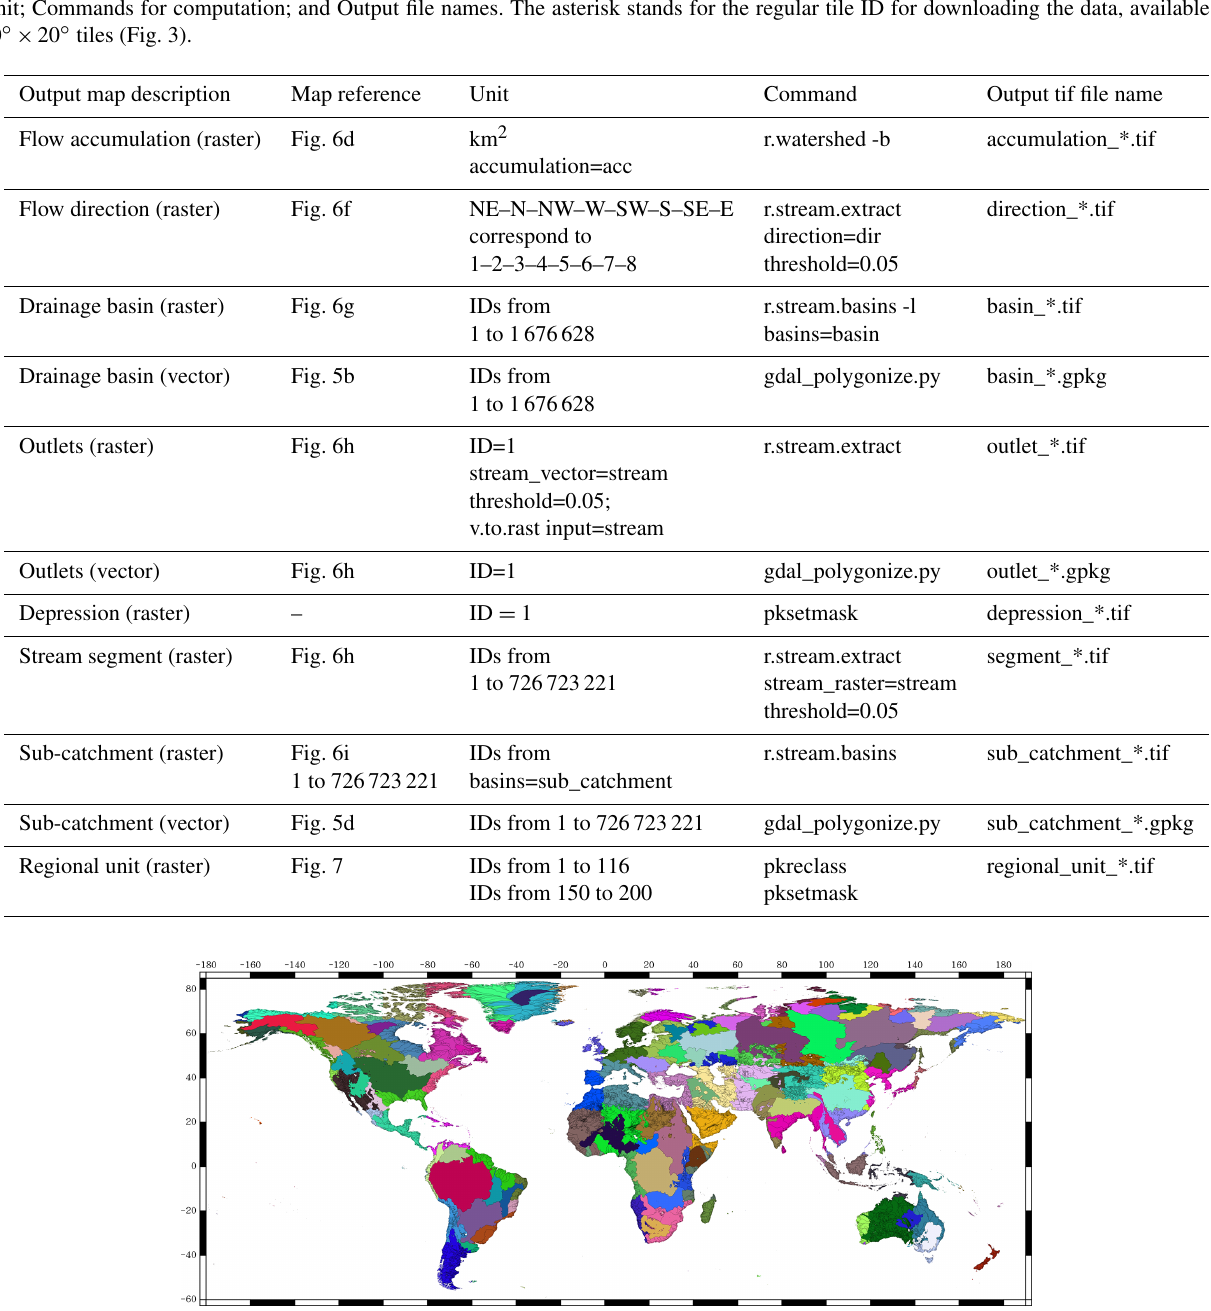
Figure 7. The 166 regional units that facilitate the splitting of all the Hydrography90m layers into customisable zones, including those areas that are delimited by an entire basin. The first 116 regional units (IDs 1 to 116) include two or more entire drainage basins, e.g. the green regional unit in the north of Europe, which includes several such basins. The remaining 50 units (IDs 150 to 200) each contain one of the 50 largest drainage basins in the world, e.g. Nile basin, Amazon basin. The colour assignment is random and for illustrative purposes only. Each coloured unit holds an ID at 3 × 3arcsec grid cell resolution and serves to mask any neighbouring drainage basins that may not be within a given area of interest (see usage notes for more